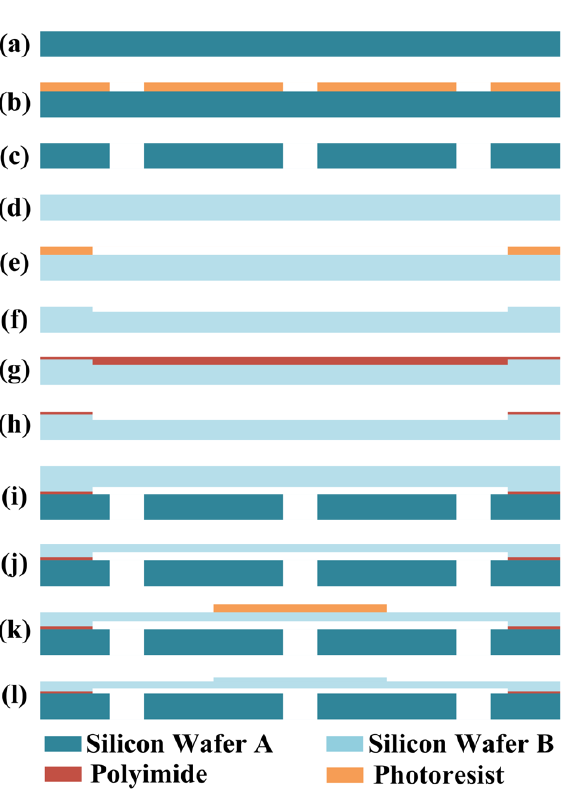
Figure 3. Vertical displacement of the valve membrane under various applied piezoelectric forces with a differential pressure 200 kPa.